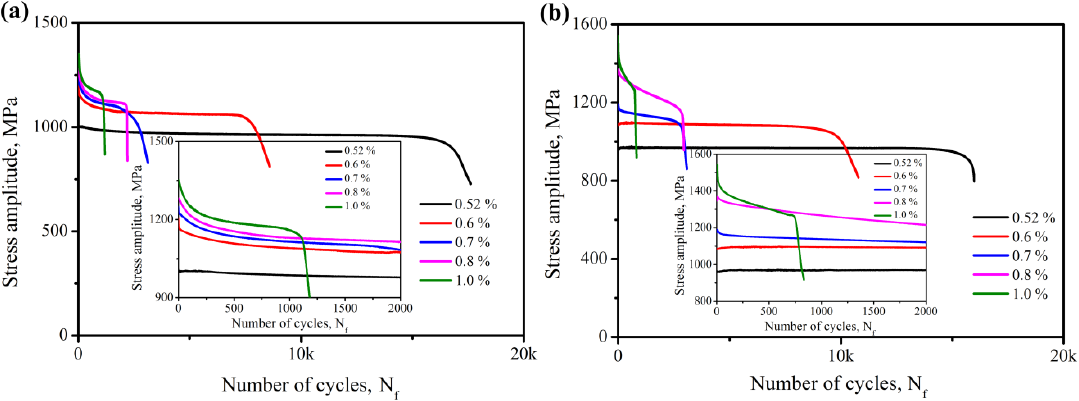
Figure 4. Cyclic stress response curves of ( a ) 22MnSi2CrMoNi and ( b ) 00Ni18Co9Mo4Ti steels (the built-in partial enlargement diagram shows the cyclic deformation behavior from 0 to 2000 cycles).